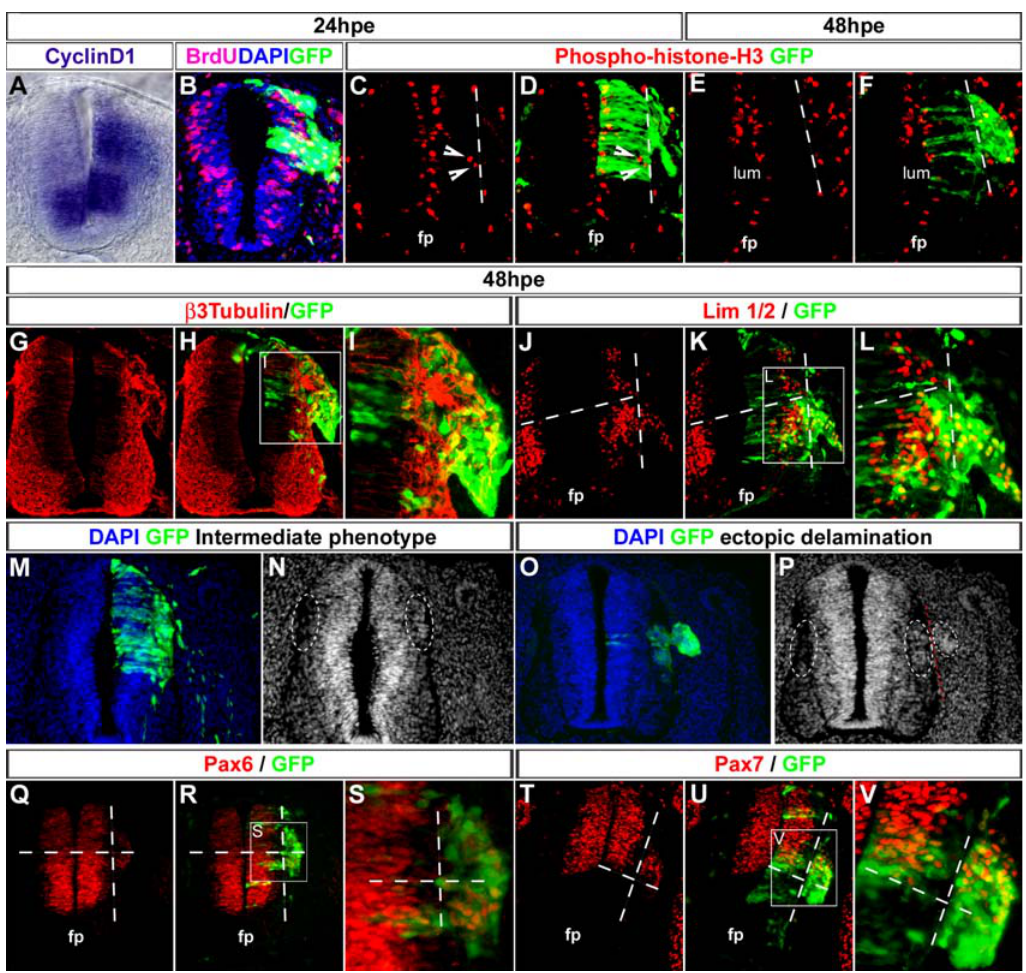
Figure 7. Ets-1Misexpression Leads to Massive Cell Movements within the Neuroepithelium. (A–V) Analysis of the effects of h-ets-1 misexpression in intermediate to ventral neural tube at 24hpe (A–D) and 48hpe (E–V). (A) Vibratome section (30 m m) of whole mount in situ hybridization using cyclin-d1 probe. (B–L, Q–V) Immunofluorescence on cryosections (10 m m) with anti-BrdU (B), anti-phosphohistoneH3 (C–F), anti- b 3-Tubulin (G-I), anti Lim-1/2 (J–L), anti-Pax-6 (Q–S), anti-Pax-7 (T–V) antibodies. (M–P) Nuclei are stained with DAPI. H-ets-1 misexpression leads to ectopic activation of cyclin-d1 expression without affecting equilibrium between cell proliferation (B–F) and cell differentiation (G–L). Ectopic h-ets-1 expression provokes cell accumulation close to the basal side of the neural tube (M–P). Interestingly, cell recruitment is detectable even when the phenotype is not strong enough to lead to ectopic delamination (M–N). These cell movements of neuroepithelial cells occur along the apico-basal axis of the neural tube and do not disturb dorso-ventral patterning (Q–V). fp, floor plate; lum,